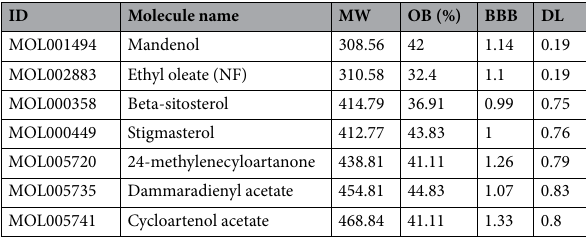
Table 1. Active compounds of AA.